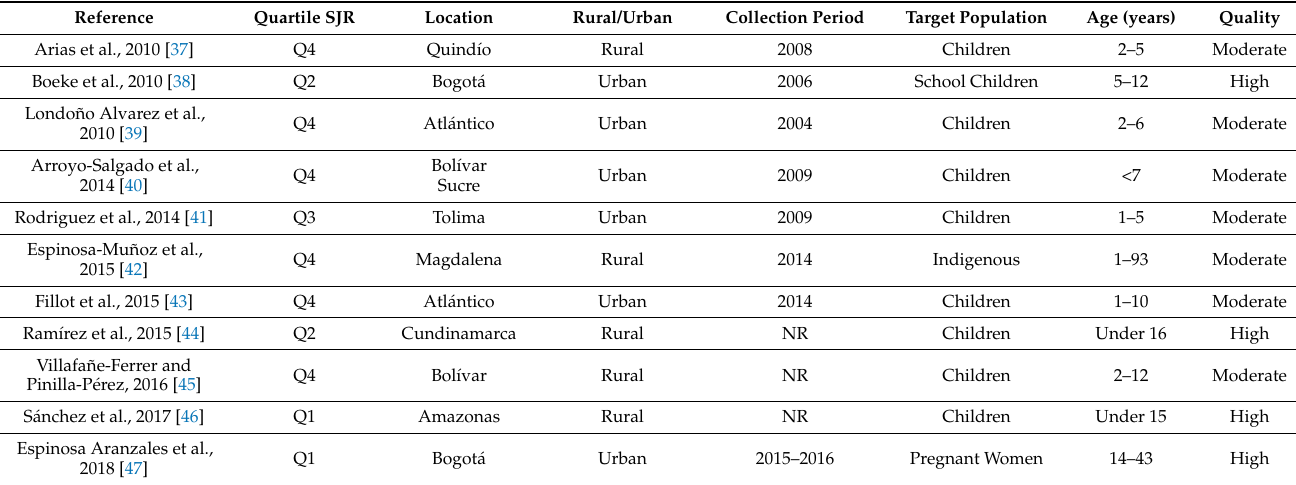
Table 1. Main characteristic of included studies.